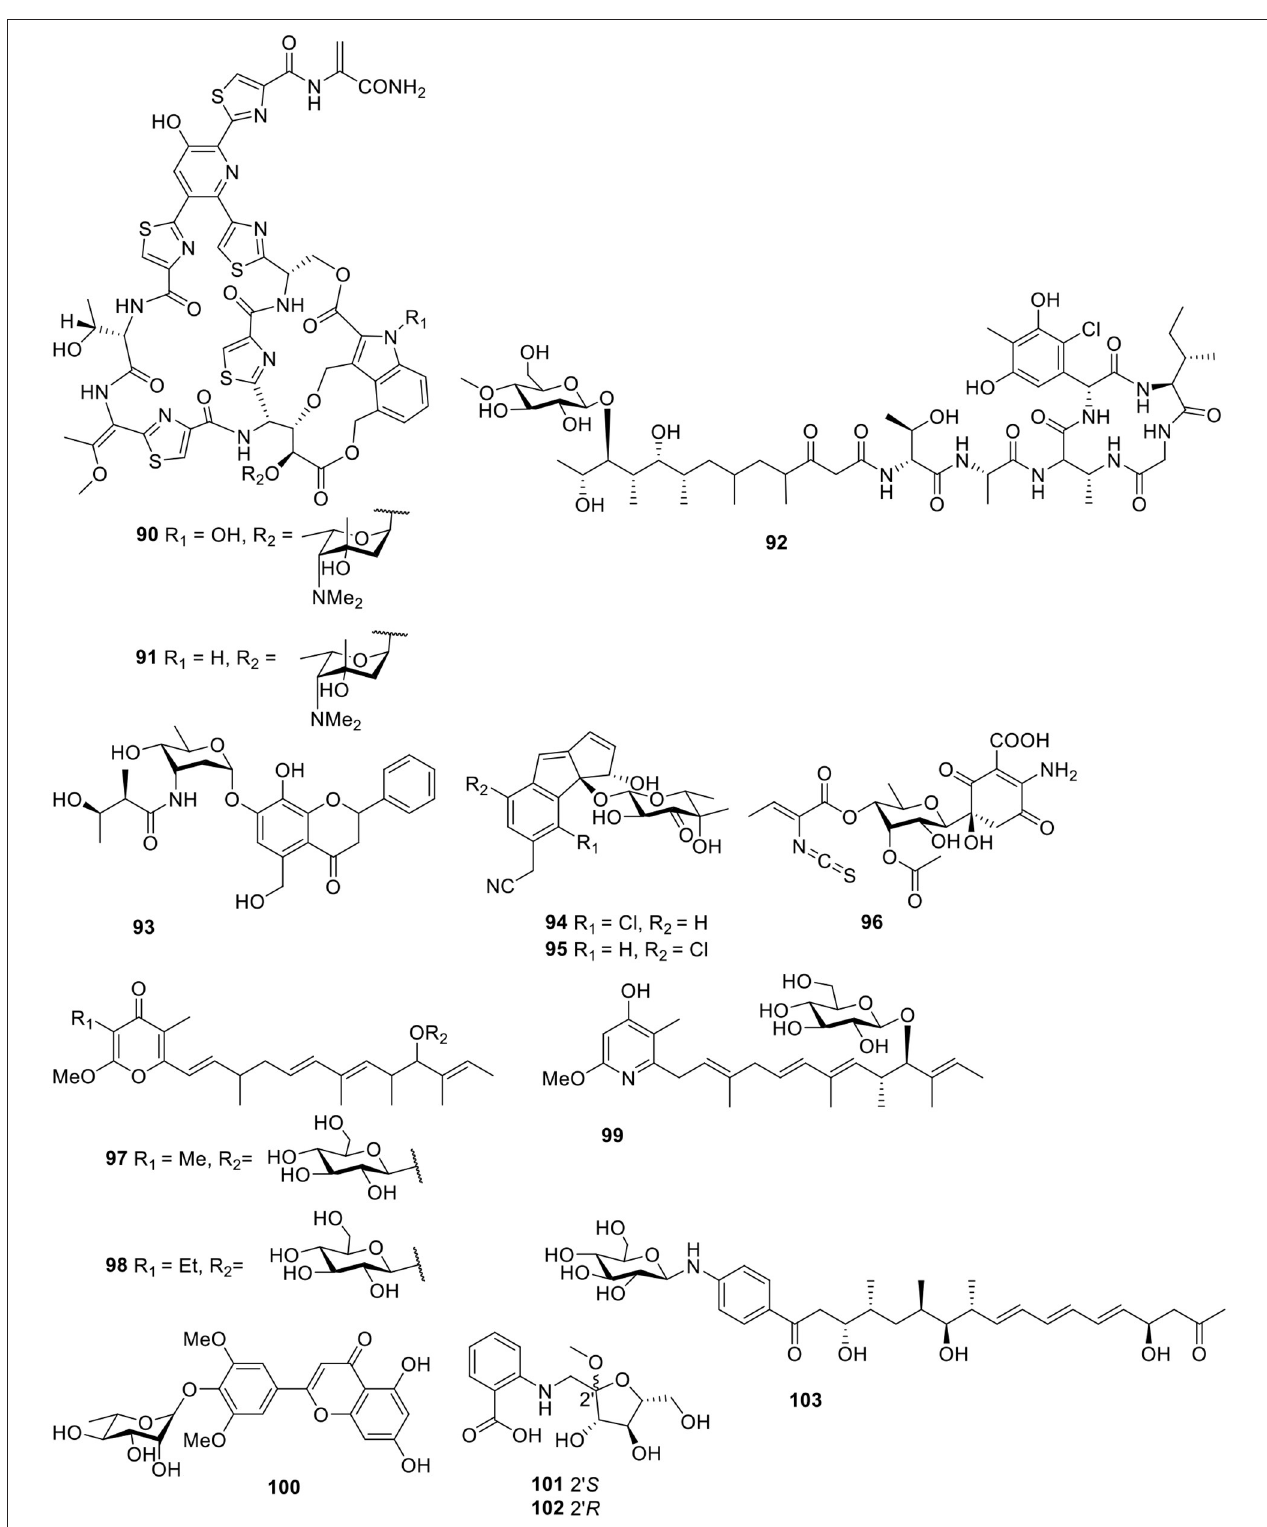
FIGURE 7 | Chemical structures of compounds 90–103 derived from marine-sourced bacteria.